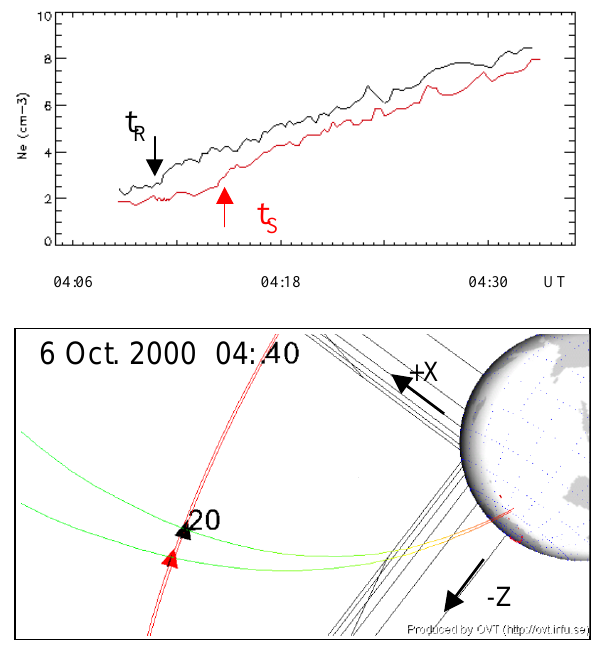
Fig. 6. Upper panel: density profiles (black for RUMBA, red for SALSA) for a time interval shown in Fig. 5. Lower panel: con- figuration of the 2 spacecraft trajectories (red) and magnetic field lines (green) plotted by the OVT visualization tool. Triangles (stan- dard Cluster color-code) show the spacecraft positions at 04:20UT. The orbit trajectory is almost perpendicular to the field lines, along which we think the density structure is